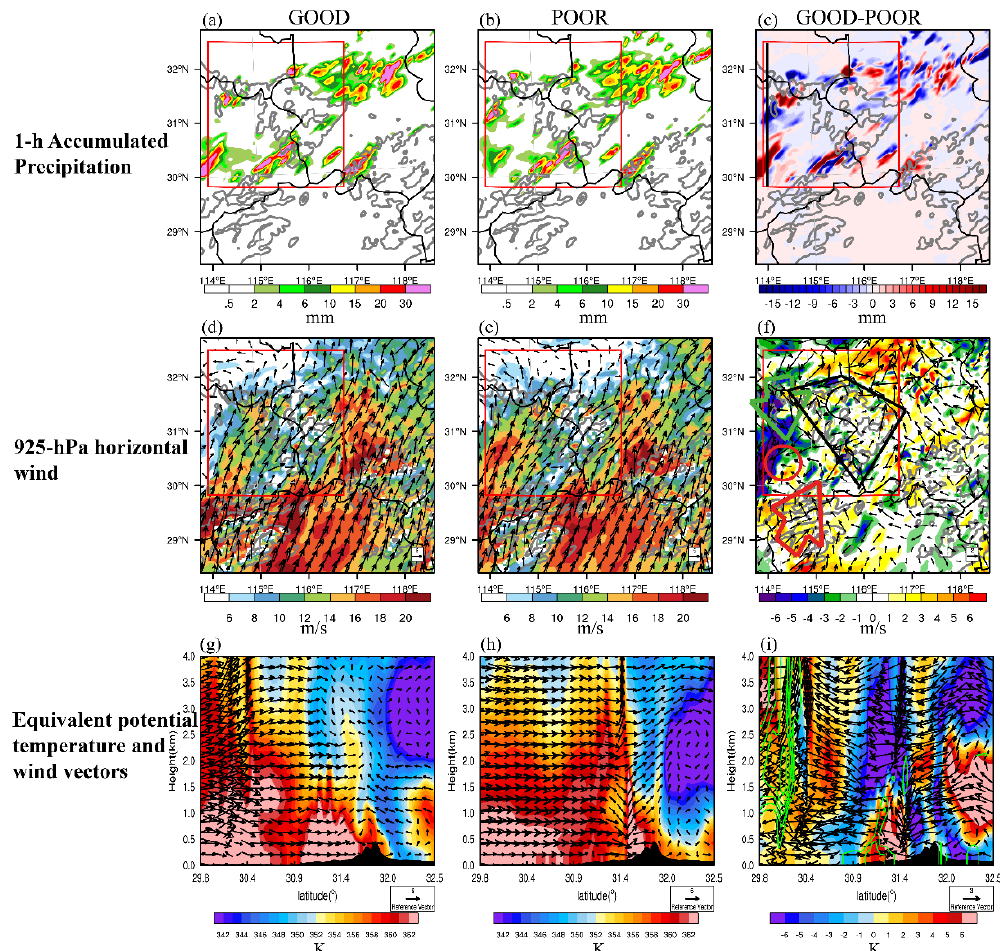
Figure 8. Environments of GOOD and POOR at 1330 UTC 6 July (1.5 h lead time) and their difference (GOOD minus POOR): ( a – c ) 1h accumulated precipitation (mm), ( d – f ) 925 hPa horizontal wind vectors and wind speed (shaded, m / s). The gray thick contour indicates the terrain height (m, contoured every 600 m). Red rectangles identify the MCS1 region. The red circle along with the rectangles indicates the convergence di ff erence region, while the black polygon outlines the general range of the Dabie Mountains. ( g – i ) Local vertical circulation (vectors, m / s) and equivalent potential temperature (shaded, K) along the black line in Figure 8c. Green lines represent the southerly wind (contoured every 2 m /